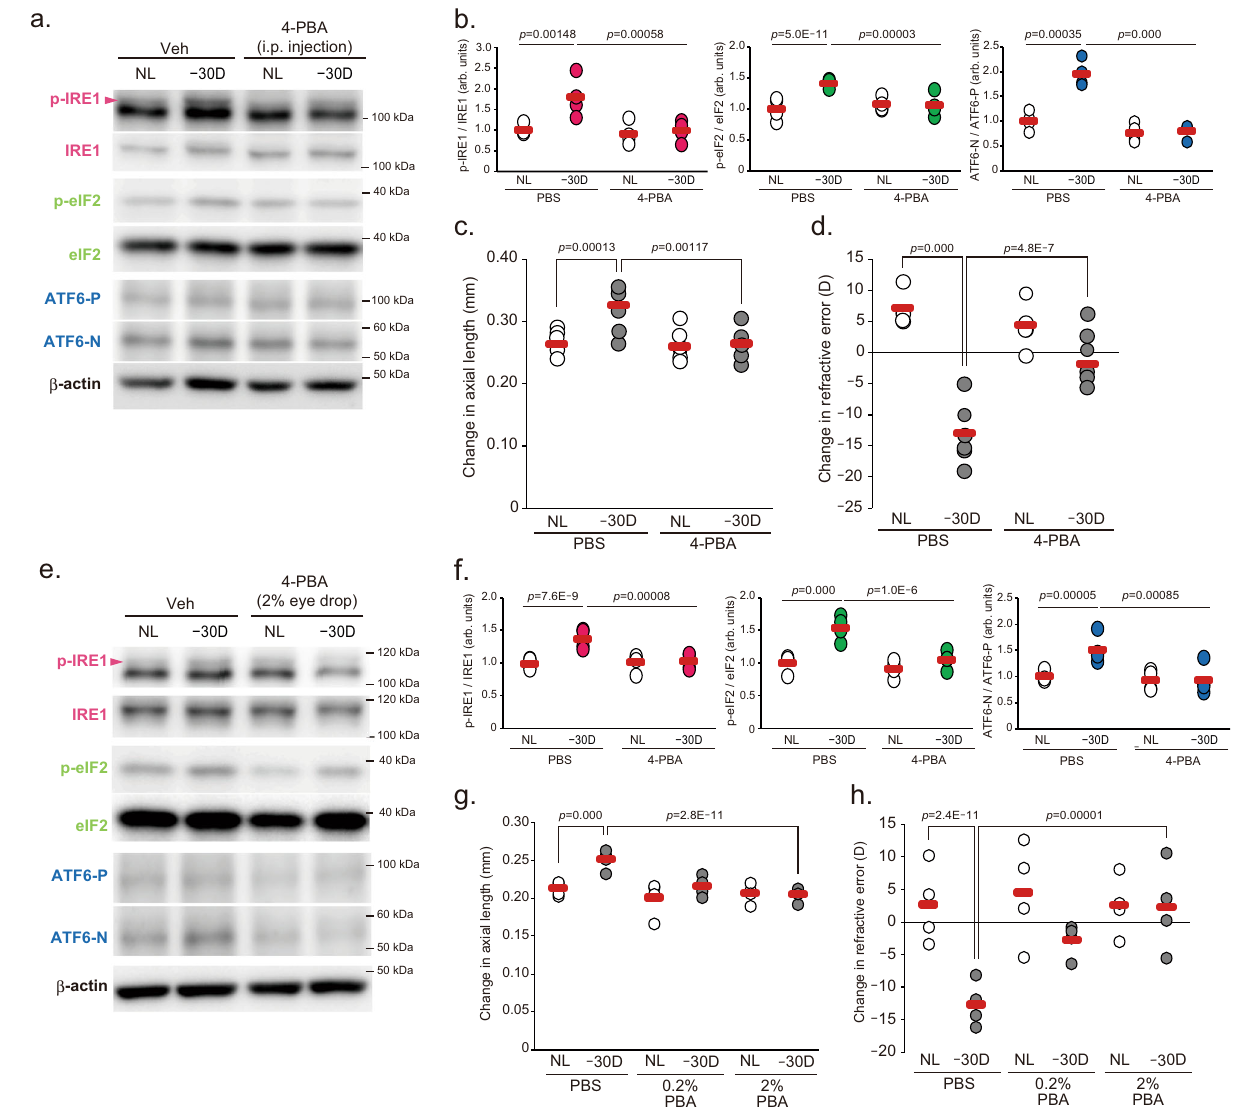
Fig. 2 | Attenuation of scleral ER stress is suf fi cient to suppress myopia development. a Intraperitoneal (i.p.) injection of 4-phenylbutyric acid (4-PBA; 200mg/kg/day) suppresses Lens-induced myopia (LIM)-induced activation in UPR branch determined by Western blotting in sclerae. NL: No Lens control, − 30D: minus30Dlens-wearingeye. b Densitometricquanti fi